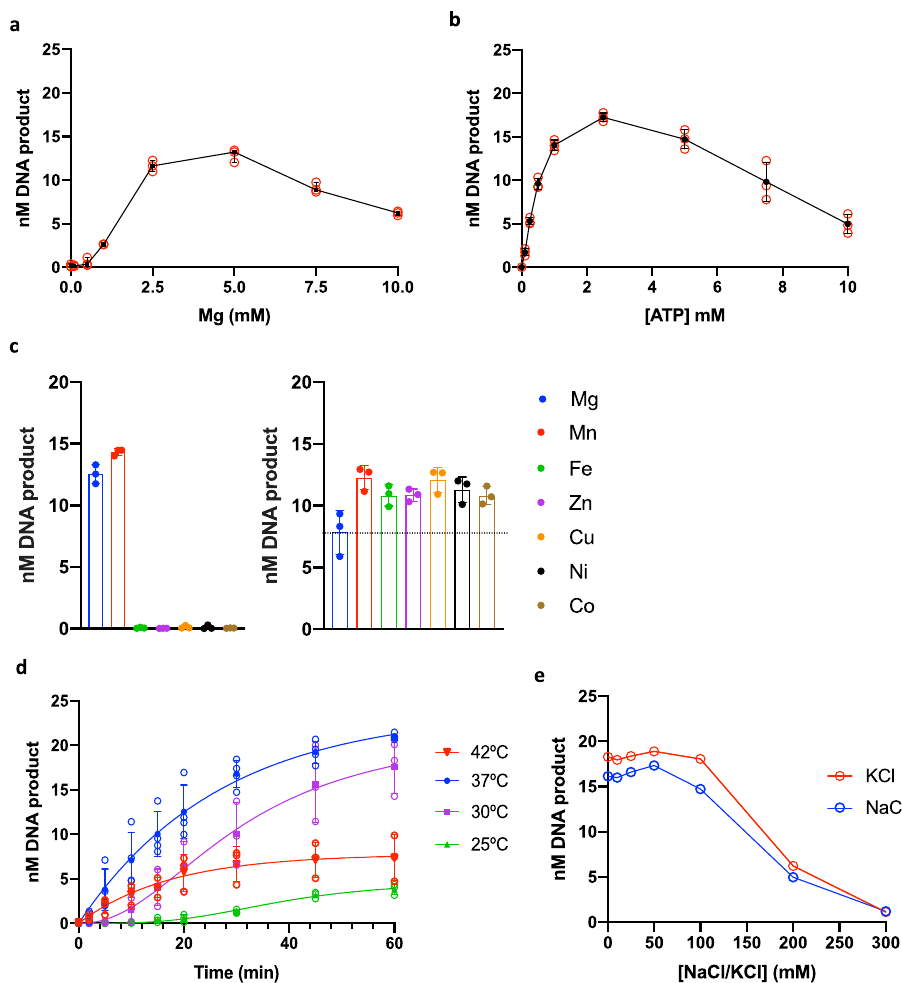
Fig. 2 Optimization of the in vitro NER system. a Dual-incision activity by drUvrABC as a function of MgCl 2 concentration. Reactions were performed at 37 °C using 25 nM F26-seq1 substrate, 0.25 µ M drUvrA1, 0.5 µ M drUvrB and 2 µ M drUvrC supplemented with 0, 0.1, 0.25, 0.5, 1.0, 2.5, 5.0, 7.5, or 10.0 mM MgCl 2 . Reactions were started by addition of 2.5 mM ATP. The graph presents the mean amount of 12 mer product (nM) released after 30 minutes (black symbols) and the standard deviation of three individual replicates shown as open red circles. b Dual-incision activity by drUvrABC as a function of ATP concentration. Reactions were performed at 37 °C using 25 nM F26-seq1 substrate, 1 µ M drUvrA1, 0.5 µ M drUvrB and 2 µ M drUvrC, and 2.5 mM MgCl 2 . Reactions were started by addition of 0, 0.1, 0.25, 0.5, 1.0, 2.5, 5.0, 7.5 or 10.0 mM ATP. The graph presents the mean amount of 12 mer product (nM) released after 45 minutes (black symbols) and the standard deviation of three individual replicates shown as open red circles. c Effects of metals on the incision activity by drUvrABC. Left: Dual incision activity in the presence of 2.5 mM of Mg (blue), Mn (red), Fe (green), Zn (purple), Cu (orange), Ni (black), or Co (brown). Reactions were performed at 37 °C using 25 nM F26-seq1 substrate, 1 µ M drUvrA1, 0.5 µ M drUvrB and 2 µ M drUvrC. Reactions were started by addition of 2.5 mM ATP. The dot plots present the mean amount of 12 mer product (nM) released after 30 minutes and standard deviation of three individual replicates shown as fi lled circles. Right: Dual incision activity in the presence of 2.5 mM Mg alone (blue), or 2.5 mM Mg supplemented with 0.25 mM of Mn (red), Fe (green) Zn (purple), Cu (orange), Ni (black), or Co (brown). Reactions were performed at 37 °C using 25 nM F26-seq1 substrate, 1 µ M drUvrA1, 0.5 µ M drUvrB and 2 µ M drUvrC. Reactions were started by addition of 2.5 mM ATP. The dot plots present the mean amount of 12 mer product (nM) released after 20 minutes and standard deviation of three individual replicates shown as fi lled circles. The dashed line indicates the extent of incision in the presence of Mg alone. d Effects of temperature on the drUvrABC incision activity. Time-course experiments were performed at 25 (green), 30 (purple), 37 (blue), and 42 °C (red) for 1 hour. The graph presents the mean amount of 12 mer product (nM) released at each timepoint ( fi lled triangles) and standard deviation of at least three individual replicates shown as open circles. e Effects of salt on the drUvrABC incision activity. Dual incision activity by drUvrABC as a function of NaCl (blue) and KCl (red) concentration. Reactions were performed at 37 °C using 25 nM F26- seq1 substrate, 1 µ M drUvrA1, 0.5 µ M drUvrB and 2 µ M drUvrC in reaction buffer containing 0, 10, 25, 50, 100, 200, or 300 mM NaCl or KCl.